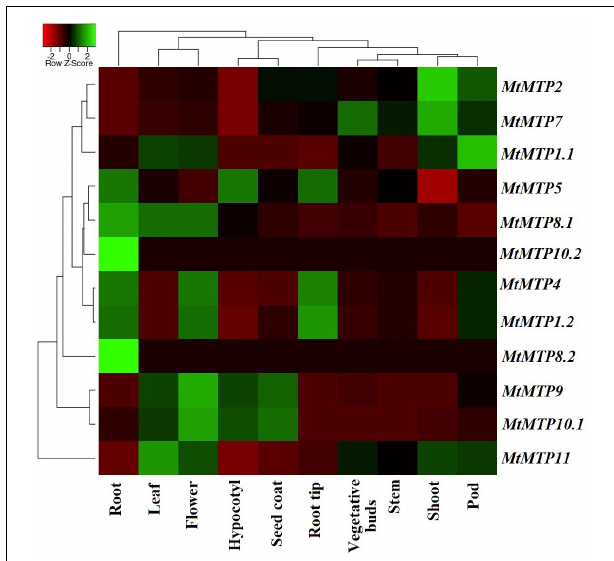
FIGURE 8 | The heat map of 12 M. truncatula MTP gene expression profiles based on RNA-seq data. The previous expression has been shown in the root, leaf, flower, hypocotyl, seed coat, root tip, vegetative bud, stem, shoot, and pod